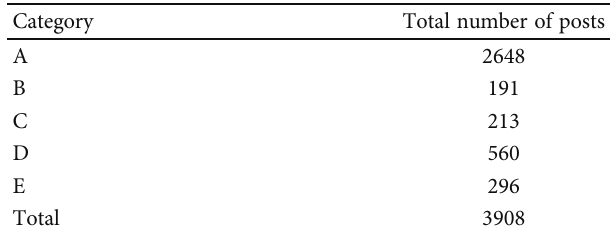
Table 2: Number of posts from the links in each